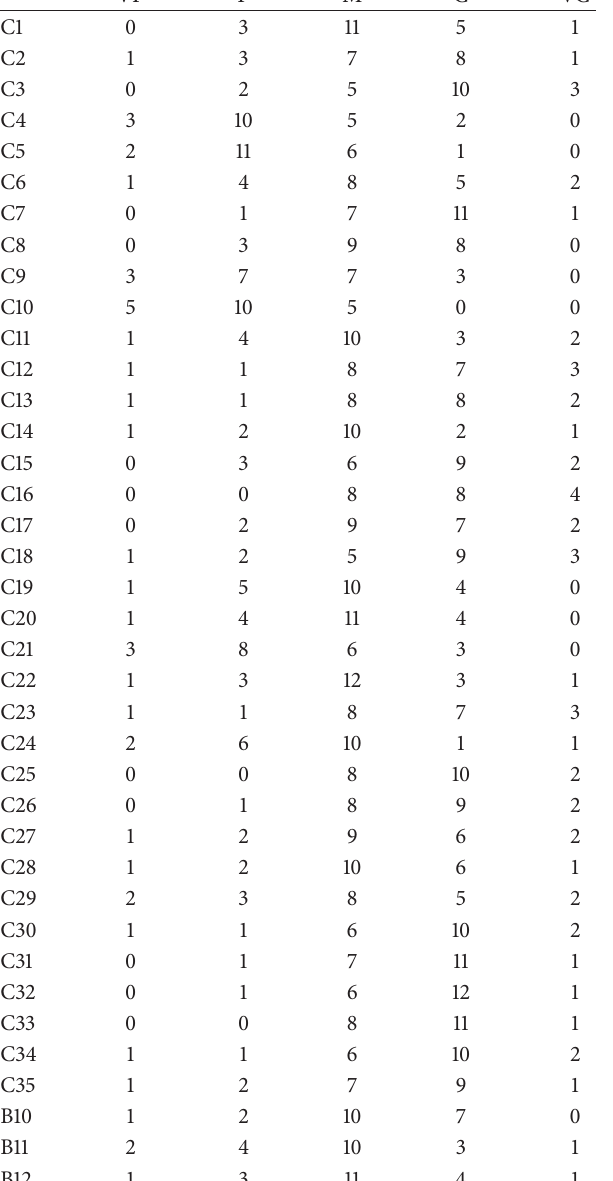
Table 10: The summarization of the initial date of the evaluation for the 4-level factors.